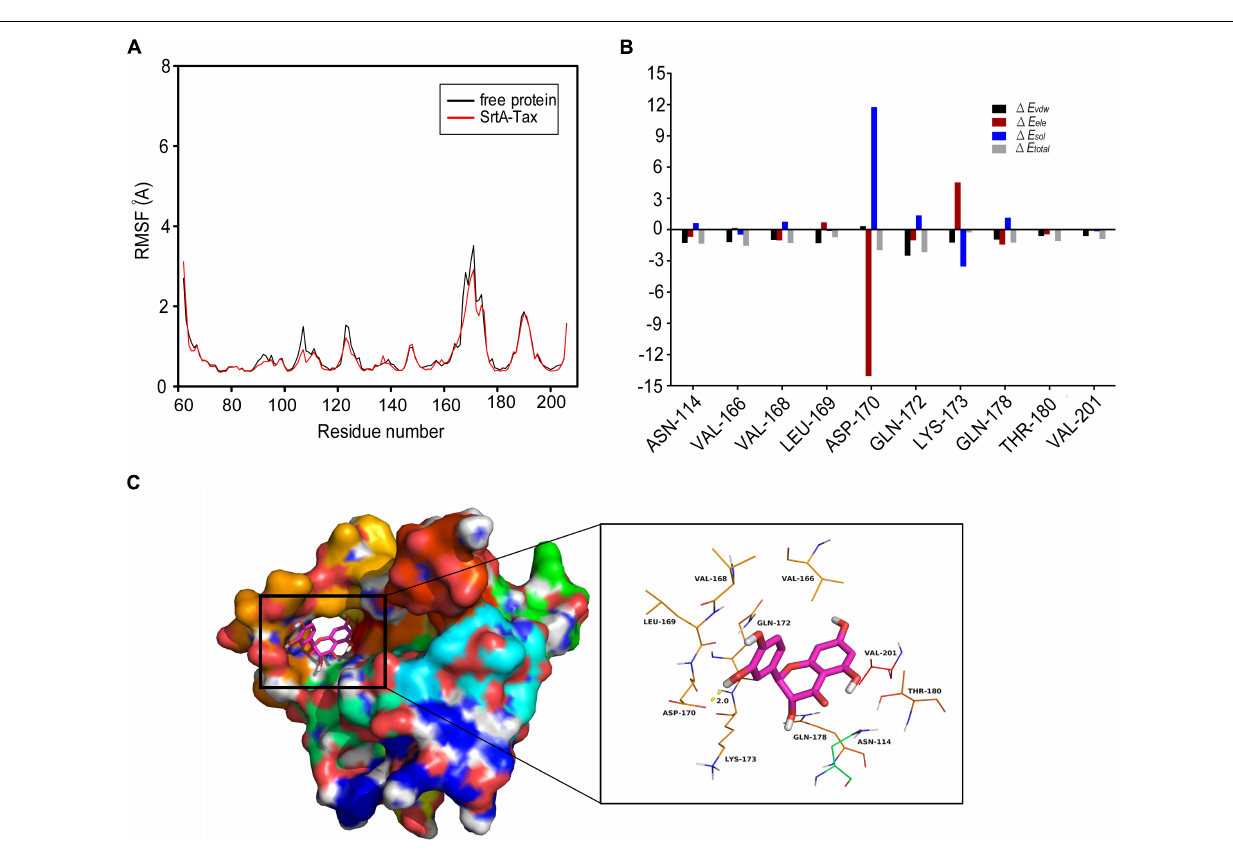
FIGURE 5 | Molecular modeling of the interaction between Tax and SrtA. (A) RMSF (Å) graph of free-SrtA (black) and the SrtA-Tax (red) complex during 40-ns MD. (B) Docking model of Tax with SrtA during a molecular dynamics simulation. (C) Binding free energy decomposition in each residue between Tax and modeled S. aureus